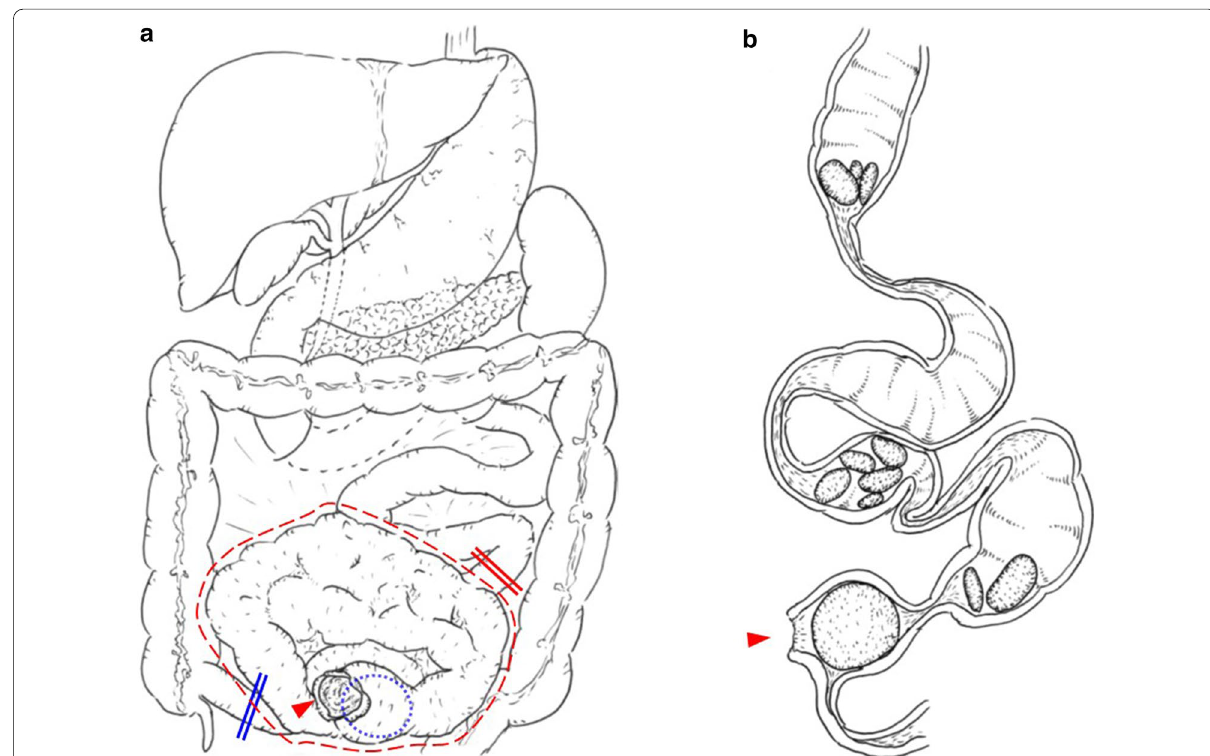
Fig. 3 Schematic illustration of the intraoperative findings and resected specimens. a The severely adhered intestine, that is, the so-called “frozen pelvis” (red dashed line); intraluminal 5-cm stone (blue dotted line) near the perforation site of the small intestine (red arrowhead); proximal resection line on the anal side 1 m from the ligament of Treitz (red double line); and distal resection line on the oral side 1 m from the ileal end (blue double line); b The resected small intestine has many stenotic lesions and multiple stones in the prestenotic dilated lumen. The largest 5-cm stone and perforation site (red arrowhead) are located immediately on the oral side of the tightest stricture. Incidentally, the upper side is proximal, and the lower side is distal in the